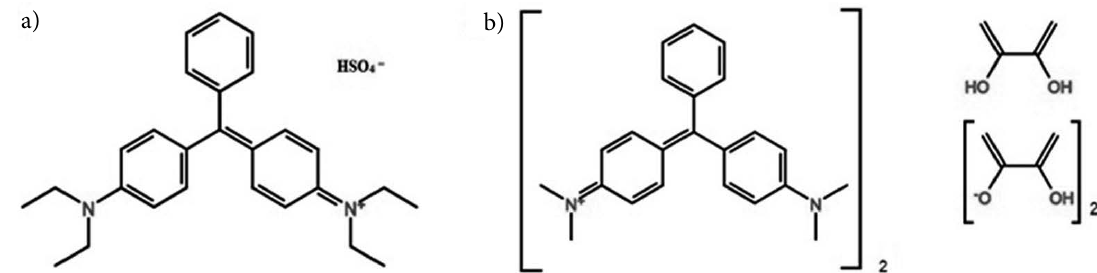
Figure 1. The chemical structure of brilliant green (a) and malachite green (b)